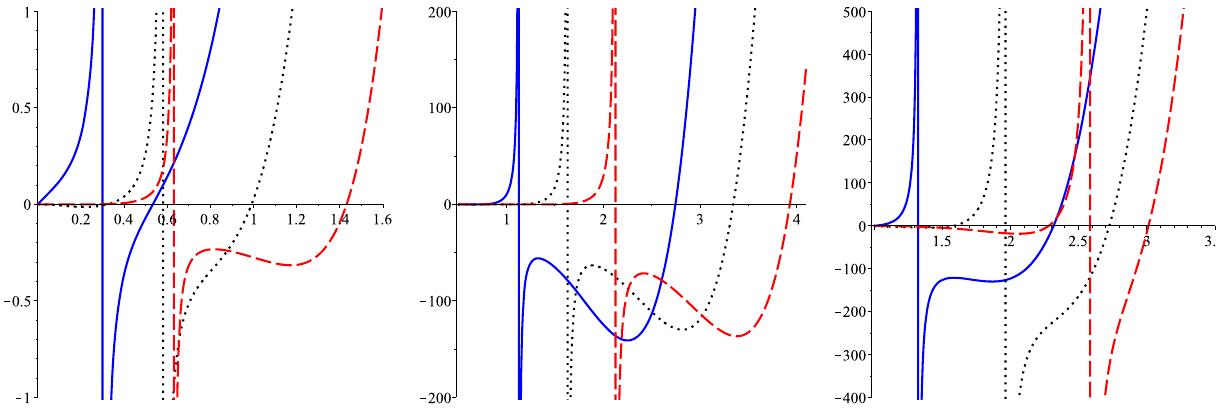
Fig. 16 C P , X versus r + with one divergence point for topological i black holes in d = 7 (solid lines), d = 8 (dotted lines) and d = 9 (dashedlines).Plotshavebeendepictedwithdifferentscales.Leftpanel: for k = + 1, q = 0, α = 1, P = 1 / 8 π , m = 0 . 1, c 0 = 1, c 1 = − 10,